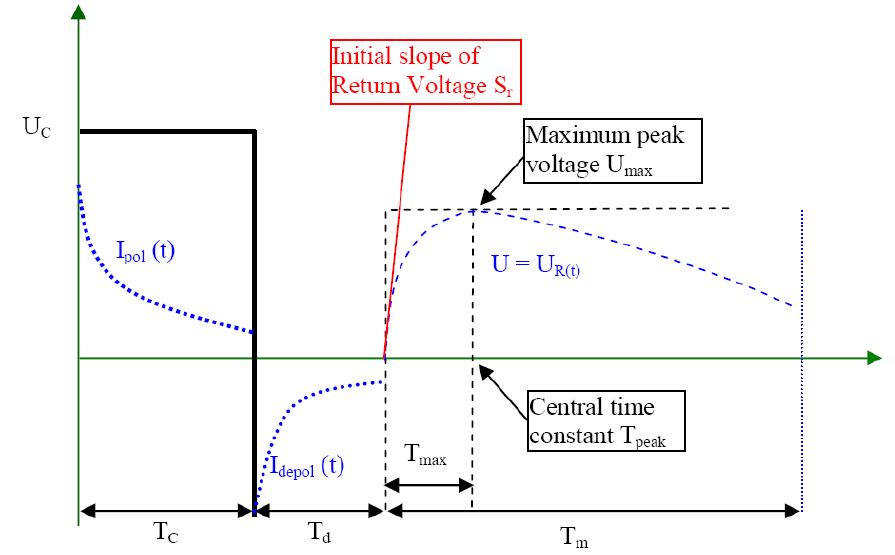
Figure 3. Schematic diagram of the recovery voltage measurement (RVM) process.